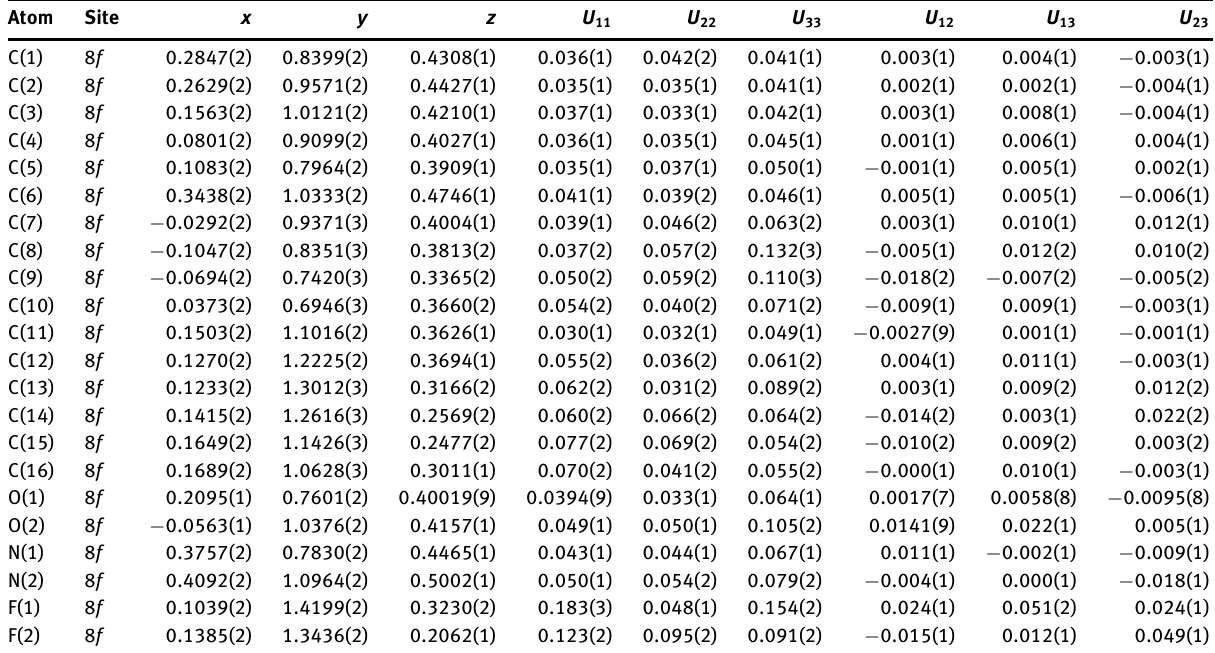
Table 3: Atomic displacement parameters (Å 2